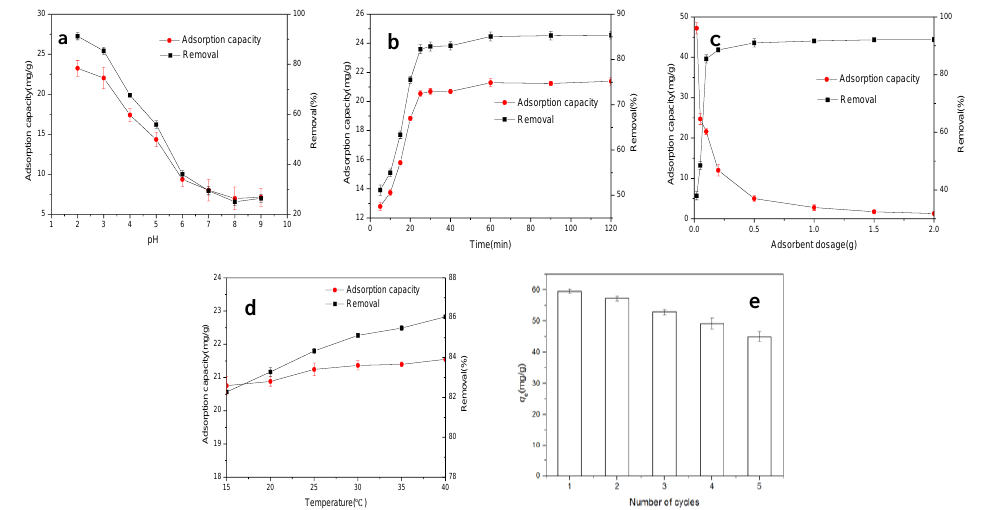
Figure 1. Plots of ( a ) initial solution pH effect ( T = 25 °C, m / V = 2 g/L, t = 60 min, and C 0 = 50 mg/L), ( b ) contact time ( T = 25 °C, pH = 3.0, m / V = 2 g/L, and C 0 = 50 mg/L), ( c ) adsorbent dosage ( T = 25 °C, pH = 3.0, t = 60 min, and C 0 = 50 mg/L), ( d ) temperature (pH = 3.0, m / V = 2 g/L, t = 60 min, and C 0 = 50 mg/L), and ( e ) regenerated Typha angustifolia activated carbon on Cr adsorption capacity and/or removal efficiency on Typha angustifolia activated carbon, respectively.